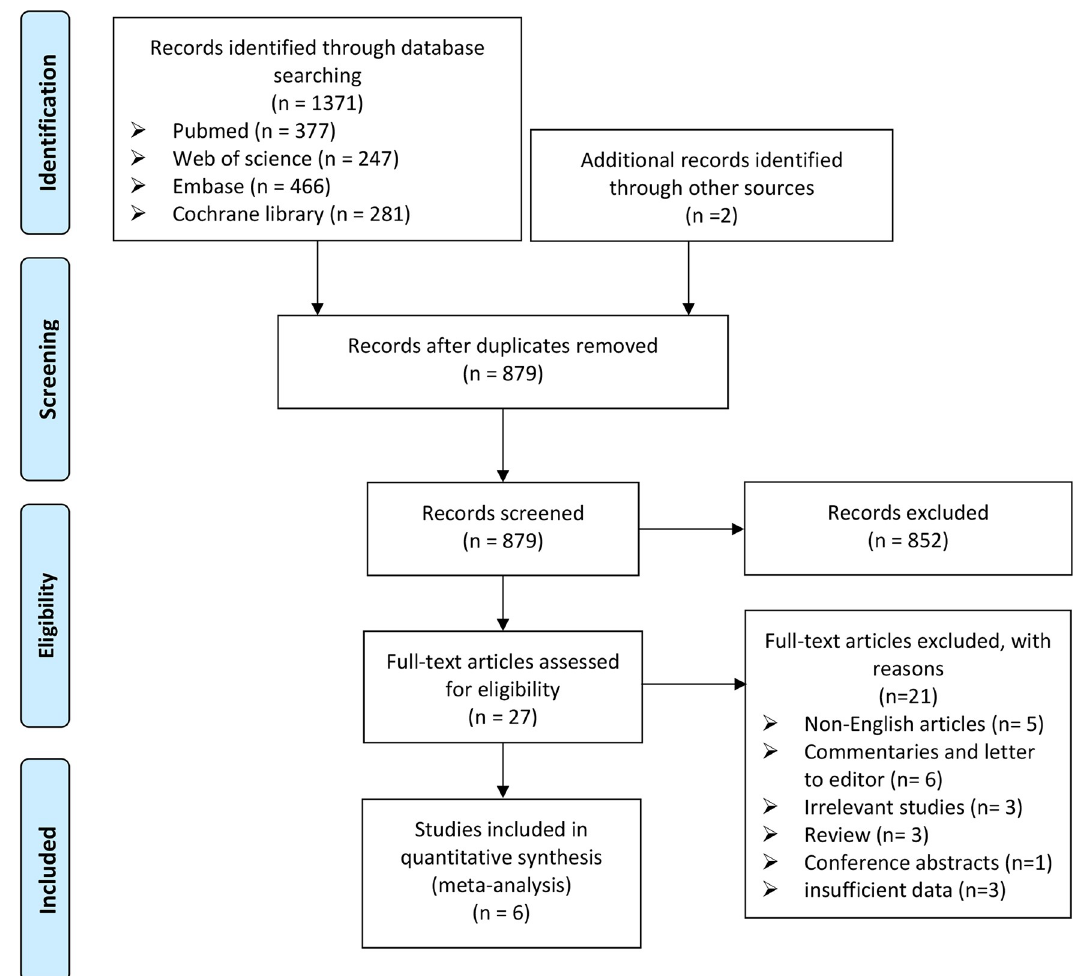
Fig 1. PRISMA flow diagram of study selection process in this